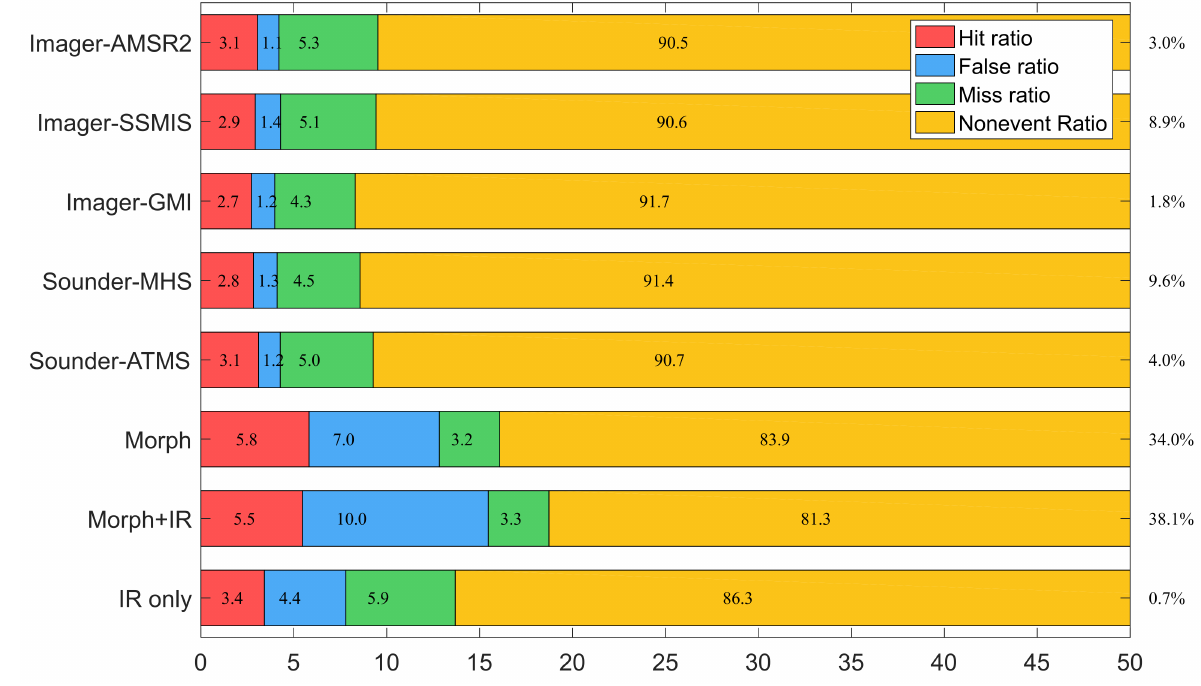
Figure 4. Hit, miss, false, and nonevent ratios for each input source in IMERG. The values at the right indicate the sample ratio.